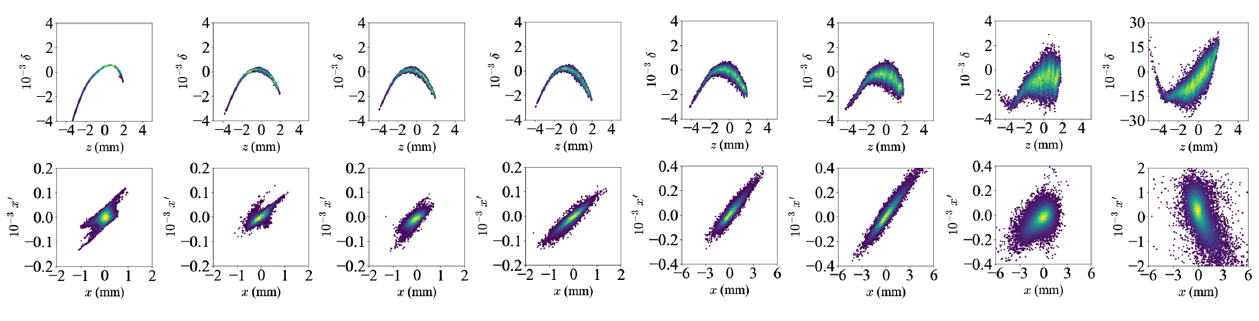
FIG. 28. Simulated x − x 0 and z − δ distributions after each of the 8 LINAC passes for CBETA 4-turn with Q ¼ 5 pC.